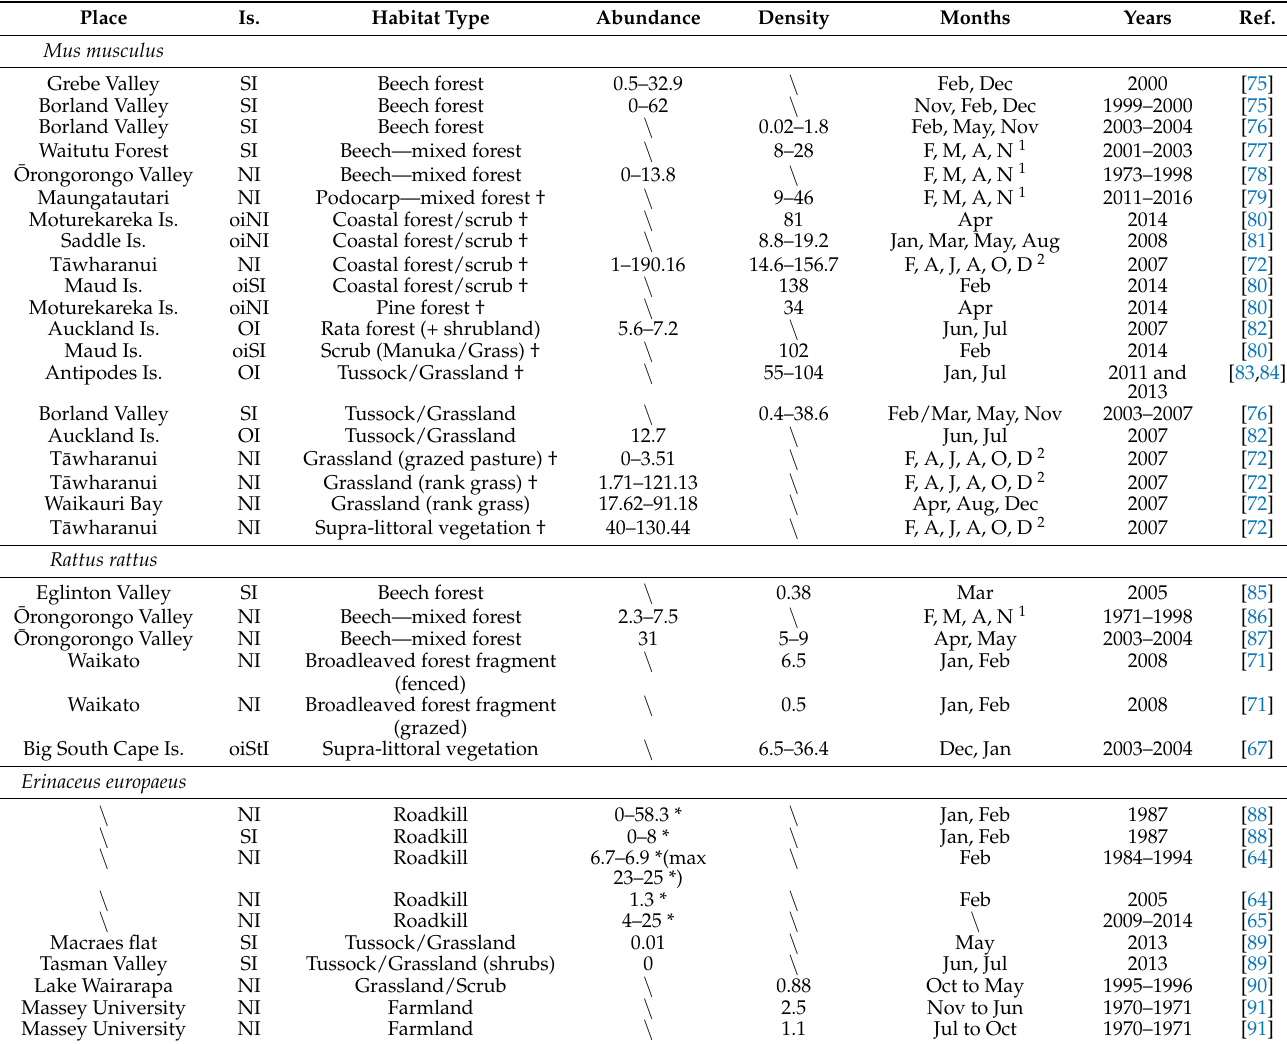
Table 1. Indices of relative abundance (in captures or corrected captures/100 trap-nights, or * in sighting/100 km) and density estimates (individuals per hectare) published in the literature for mice ( Mus musculus ), rats ( Rattus rattus ) and hedgehogs ( Erinaceus europaeus ) in New Zealand. The table was adapted and completed from [68] with the kind permission of the authors. Only literature published after 2004 was searched for rodents.